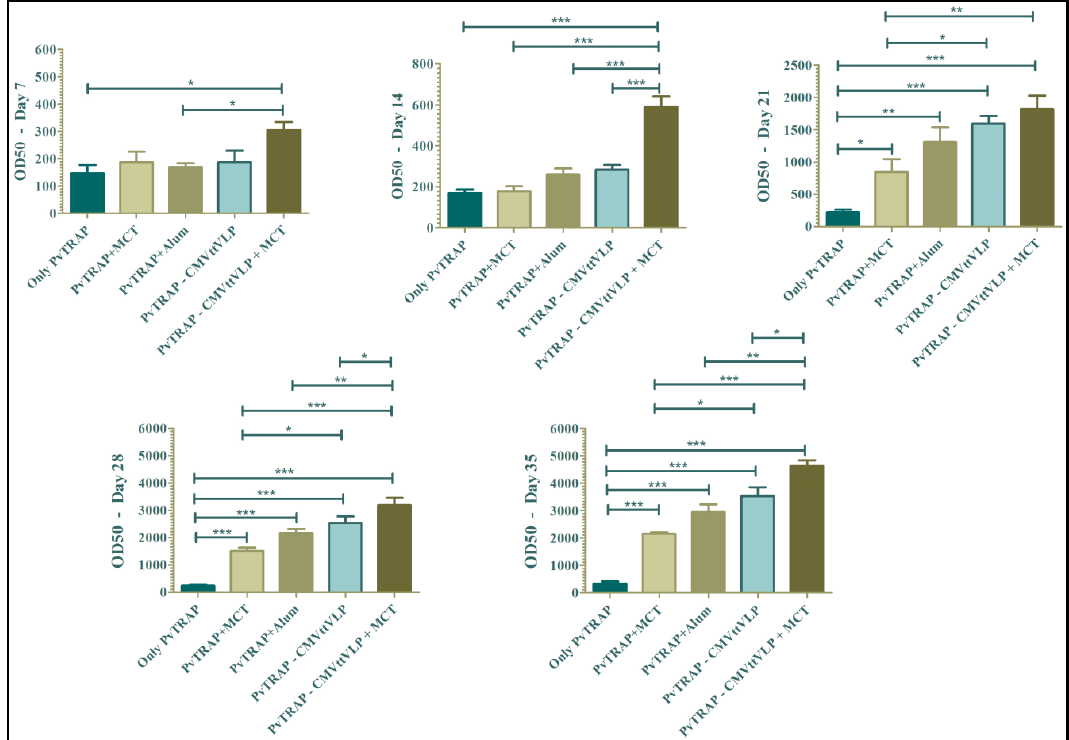
Figure 4. Assessment of kinetics of antibody production: the figure shows IgG total of all groups of mice bled weekly, from Day 7 (one week after the first vaccination) to Day 35 (one week after the second boost). The results were analysed using GraphPad Prism software applied to assess the means of five groups by one-way analysis of variance (one-way ANOVA). The values observed in the negative control group were subtracted from the titres of the other experimental groups. Note: *** = p value < 0.0001; ** = p value < 0.001; * = p value < 0.01.